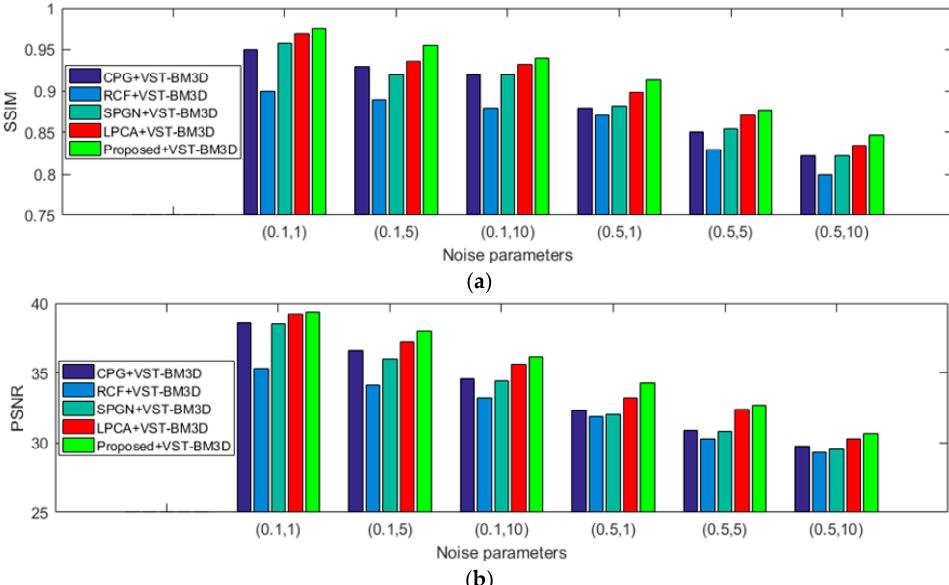
Figure 12. SSIM and PSNR comparison results of different PGN estimators with VST-BM3D for blind de-noising on the 134 selected images at different noise parameters. ( a ) Comparison results of SSIM; ( b ) comparison results of PSNR.